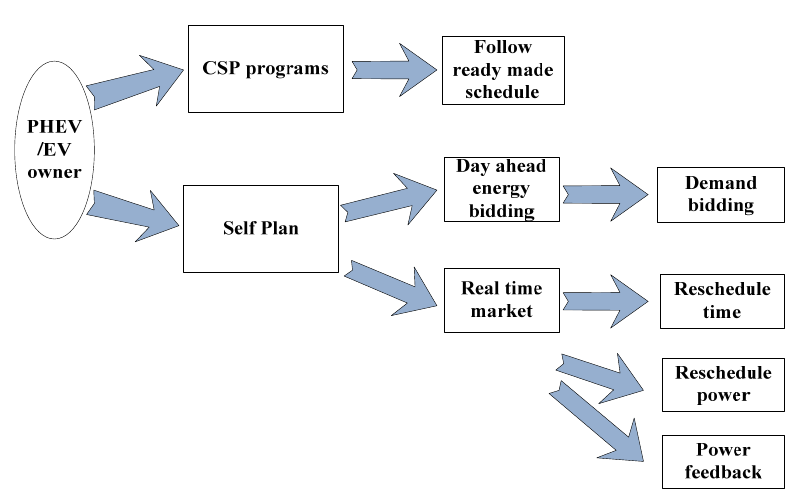
Figure 2. Choice of